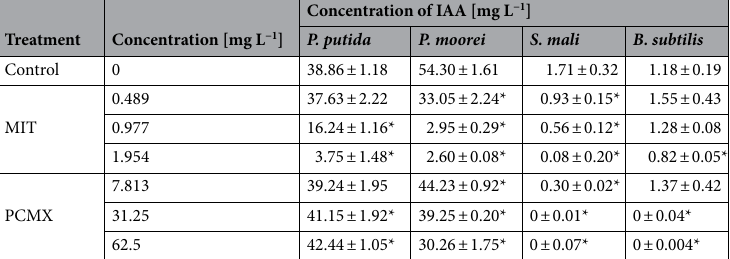
Table 1. Production of IAA by tested bacterial strains supplemented with MIT or PCMX after 48 h of incubation. Data are expressed as the average IAA concentration ± SD (n = 4). The presented results were analysed using the Mann–Whitney U test with *p <